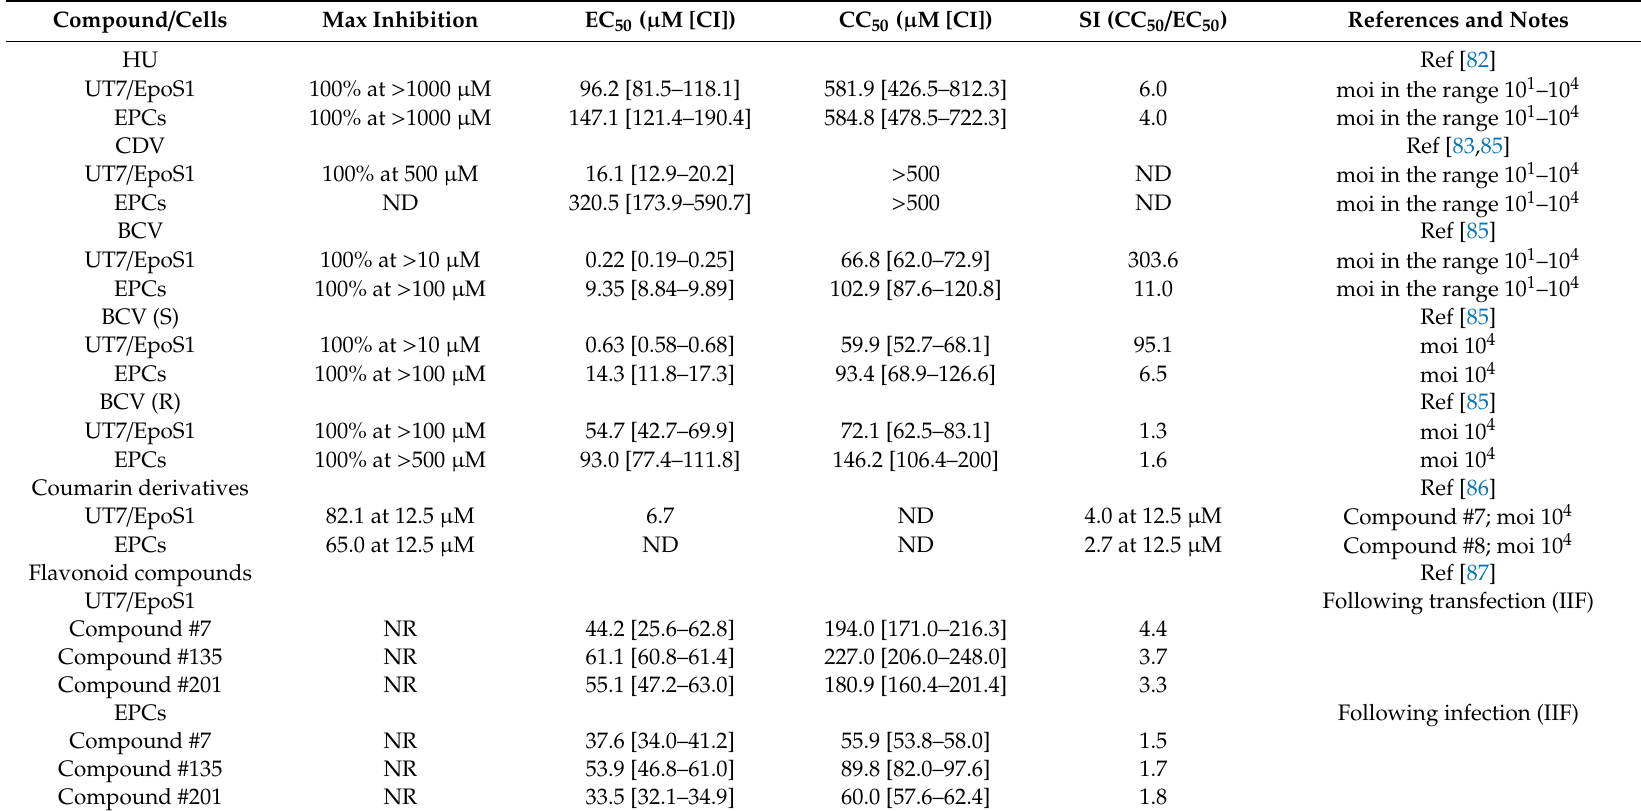
Table 1. Compounds with reported activity against